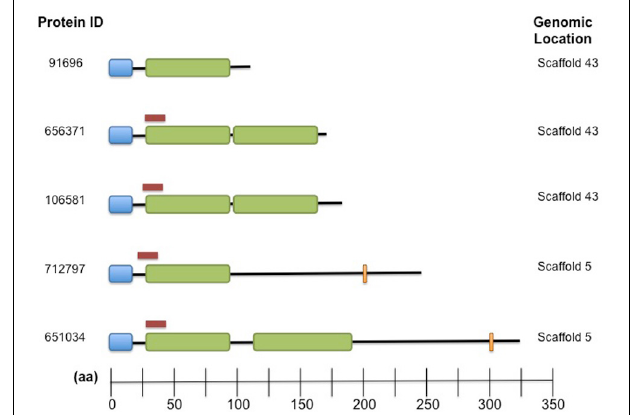
FIGURE 8 | Family 9417 proteins harbor both signal peptides and CFEM domains domains and colocalize in the Cqf genome. Domain architecture of Family 9417 protein members where signal peptides (blue), CFEM Interpro domains (green), GPI anchor sites (orange), and predicted transmembrane domains (red) are indicated for each protein. Three proteins colocalize together on scaffold 43, the remaining on scaffold 5 (indicated on